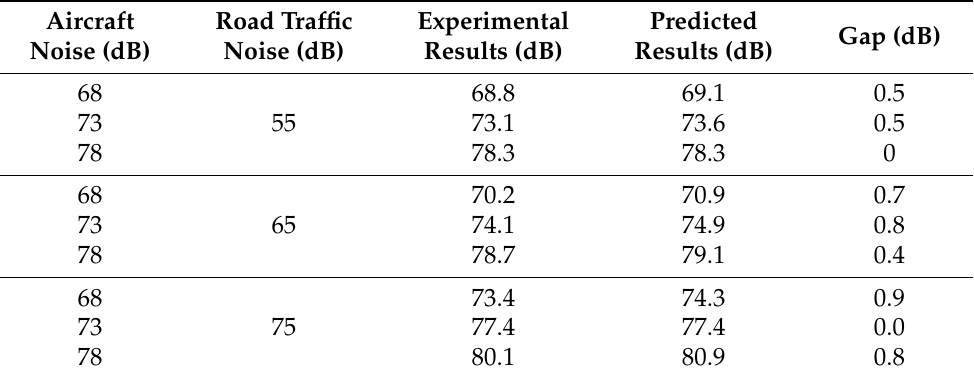
Table 3. Results of validation test for the partial loudness model with binaural